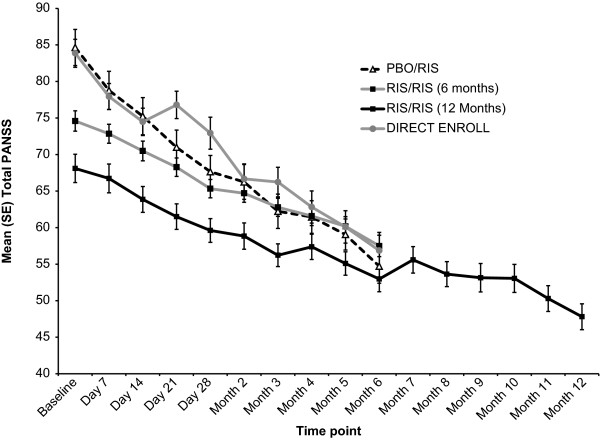
Positive and Negative Syndrome Scale (PANSS) total score over time (observed cases). Data are presented as mean (SD). Data are presented for all subjects to the 6- or 12-month end point. The RIS/RIS 6- and 12-month groups are mutually exclusive